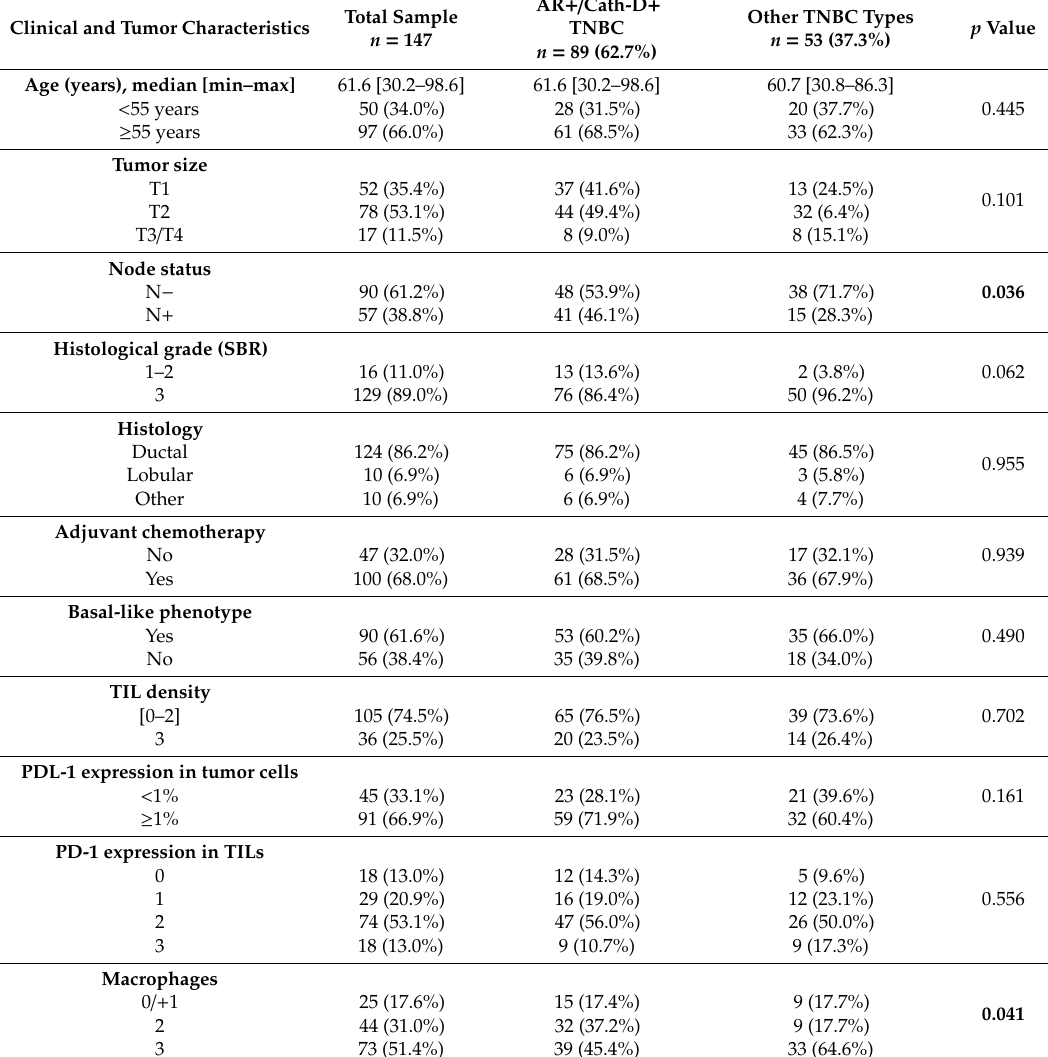
Table 2. Clinical and tumor characteristics of the whole population and according to the AR / Cath-D co-expression